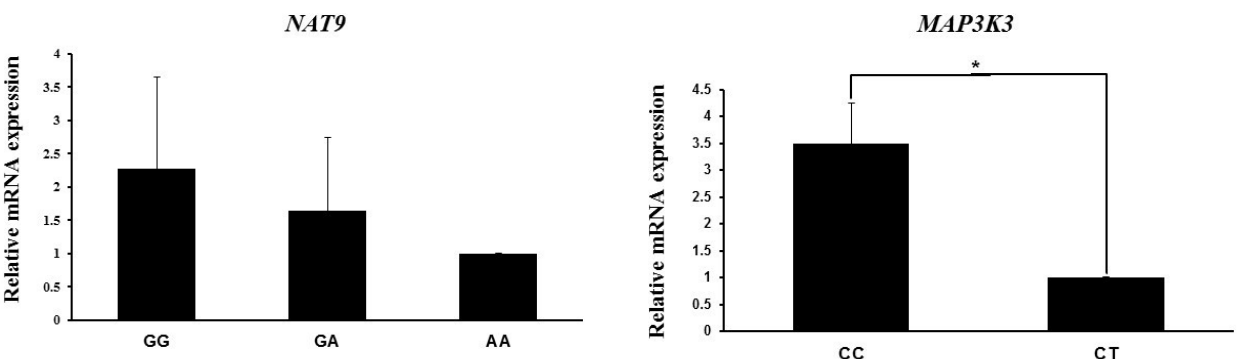
Figure 2. MAP3K3 mRNA expression in endometrial tissues ac- cording to genotype, as determined by RT-PCR. Peptidylprolyl iso- merase A (PPIA) was used as an internal control. The fold change in mRNA expression level was calculated by comparing the mRNA expression level in the genotype with the lowest expression with that the other groups. Data represent mean ± SD. ∗ p< 0 .